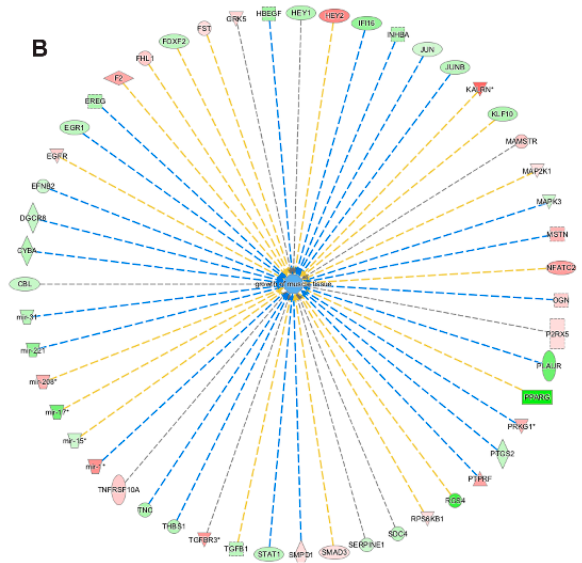
Figure 9. Biological Functional Analysis using Ingenuity pathway analysis of differentially expressed genes unique to emerin-null cells during transition from day 0 to day 1 of differentiation. ( A , B ) Biological Functional Analysis using IPA predicts inhibition of myogenesis of skeletal muscle from genes (( A ) p -value: <0.001; Z -score: − 1.067) and growth of skeletal muscle genes (( B ) p -value: <0.001; Z -score: − 0.799) as being highly enriched in the differentially expressed transcripts unique to emerin-null cells during transition from day 0 to day 1 of differentiation. The figure represents genes that are associated with a particular biological function that are altered in the uploaded dataset. Genes that are up-regulated are displayed within red nodes and those down-regulated are displayed within green nodes. The intensity of the color in a node indicates the degree of up-(red) or down-(green) regulation. The shapes of the nodes reflect the functional class of each gene product: transcriptional regulator (horizontal ellipse), transmembrane receptor (vertical ellipse), enzyme (vertical rhombus), cytokine/growth factor (square), kinase (inverted triangle) and complex/group/other (circle). An orange line indicates predicted upregulation, whereas a blue line indicates predicted downregulation. A yellow line indicates expression being contradictory to the prediction. Gray line indicates that direction of change is not predicted. Solid or broken edges indicate direct or indirect relationship, respectively.